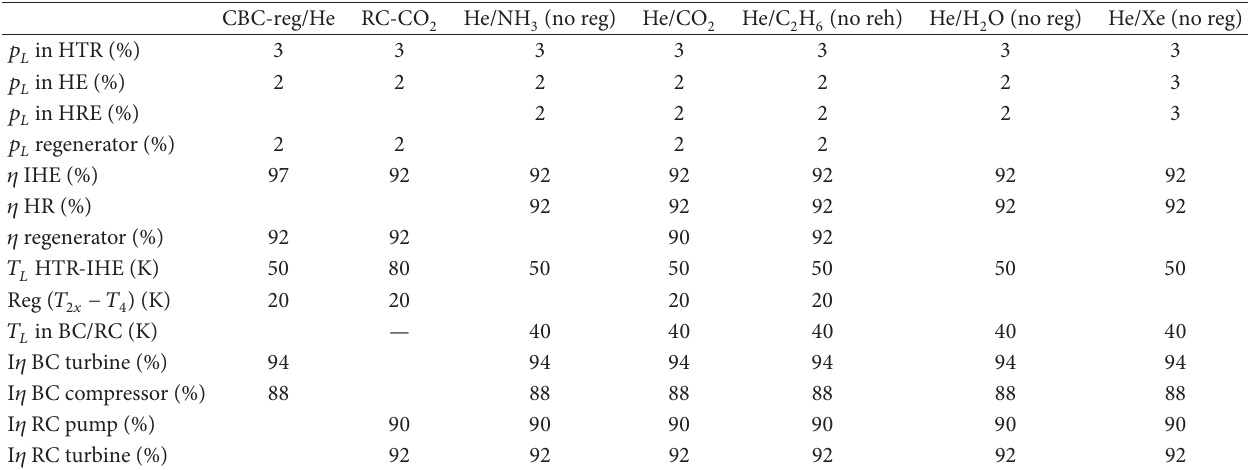
Table 4: Losses due to internal irreversibilities assumed for the case